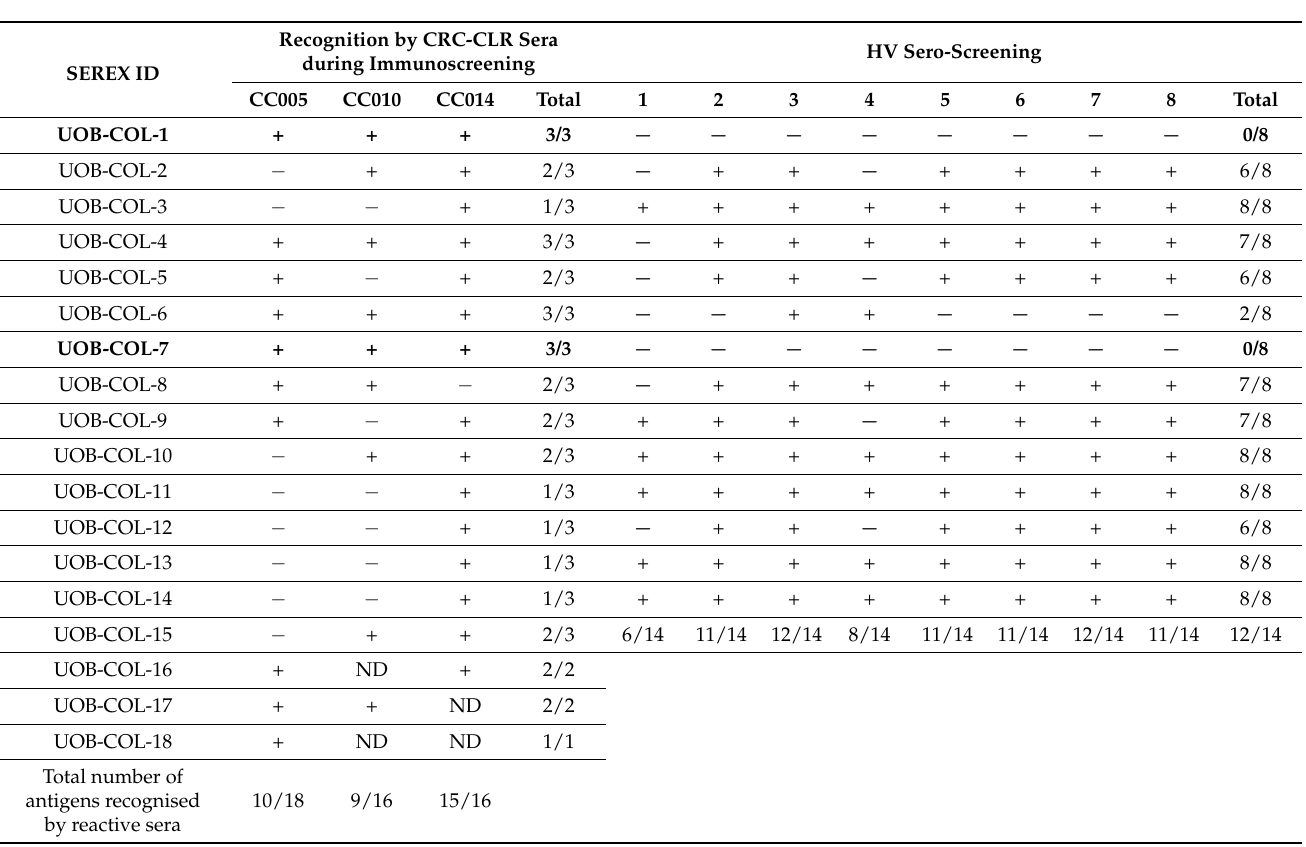
Table 2. Immunoscreening of antigens with sera from each patient with CRC CLR and HVs indicated that UOB-COL-1 and UOB-COL-7 were only recognised by patient sera.